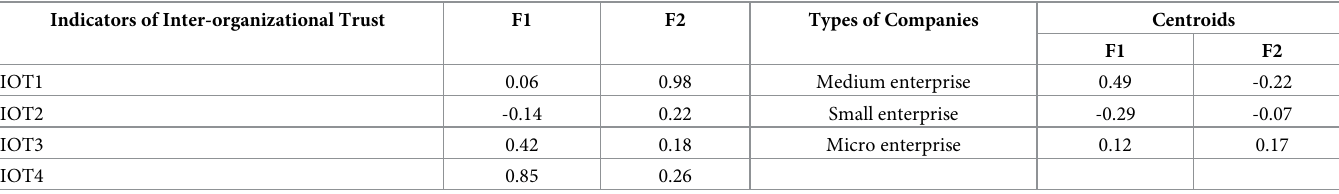
Table 14. Structure matrix and centroids’ discriminant factors of inter-organizational trust. Indicators of Inter-organizational Trust